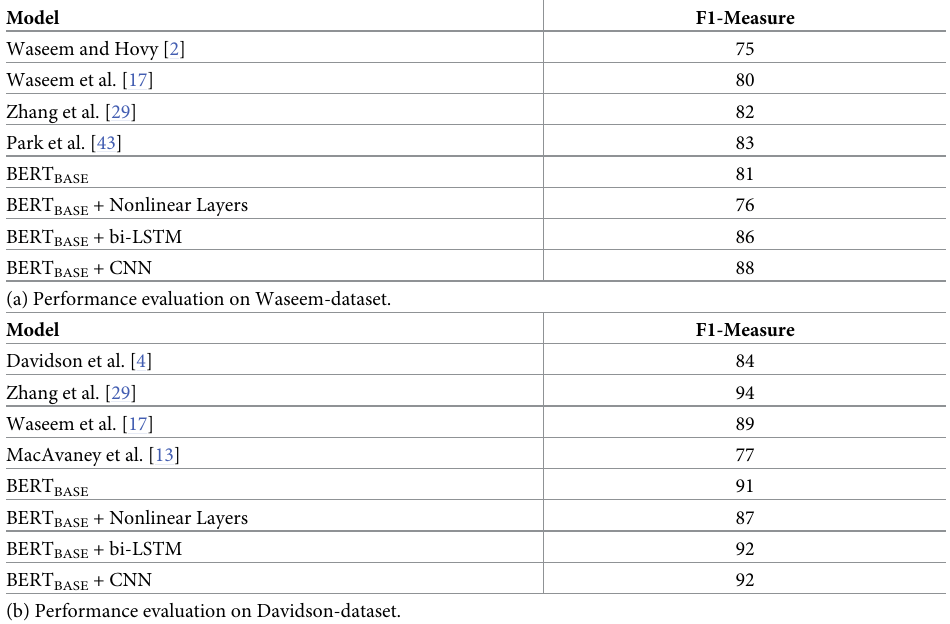
Table 2. Performance evaluation. Performance of different trained classifiers on Waseem-dataset and Davidson-data- set in terms of F1-measure are reported in a and b, respectively.